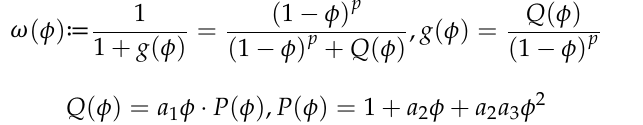
Figure 2. Schematic illustration of sharp ( 𝛤 , left) and diffusive ( ℬ , right) crack topology in a 2D solid 𝛺 with its external boundary ∂𝛺 . The external boundary ∂𝛺 can be divided into two parts: ∂𝛺 (cid:3047) and ∂𝛺 (cid:3048) , with ∂𝛺 (cid:3047) ∩ ∂𝛺 (cid:3048) = ∅ and ∂𝛺 (cid:3047) ∪ ∂𝛺 (cid:3048) = ∂𝛺 , in which it is given displacements 𝒖 ∗ for ∂𝛺 (cid:3048) and tractions 𝒕 ∗ for ∂𝛺 (cid:3047) , respectively. The outward unit normal vector of external boundary ∂𝛺 is denoted as 𝒏